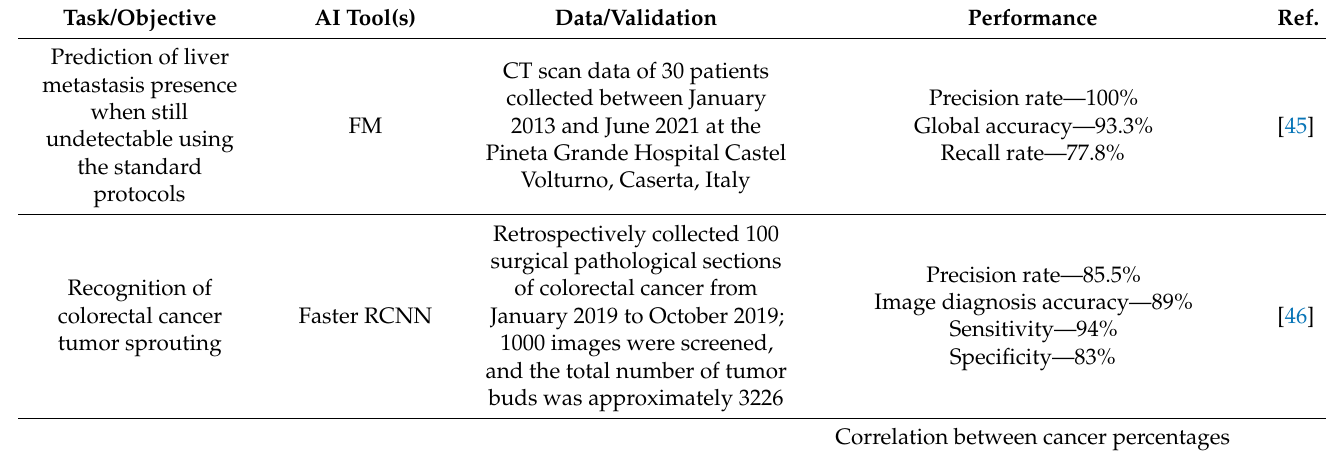
Table 4. Summary of the recent AI studies in